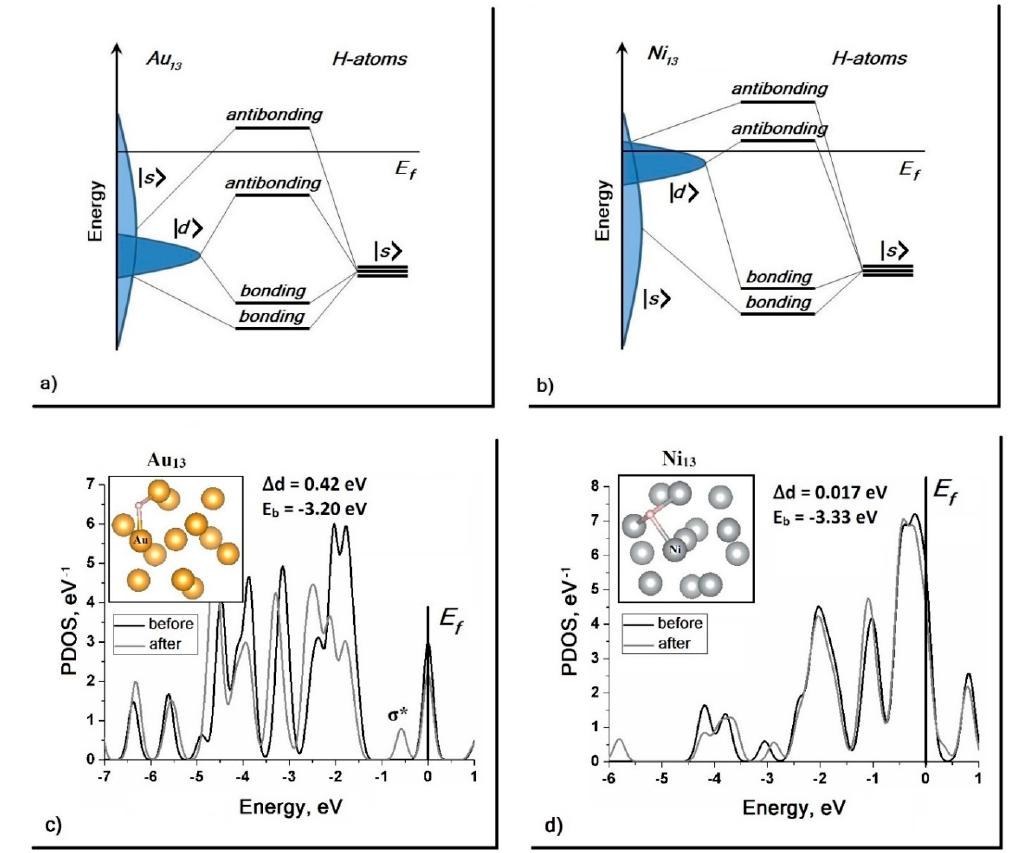
Figure 4. Diagrams of energy levels ( a,b ) and PDOS representations ( c,d ) for metal clusters interacting with a hydrogen atom: ( a,c ) Au 13 cluster; ( b,d ) for Ni 13 cluster.